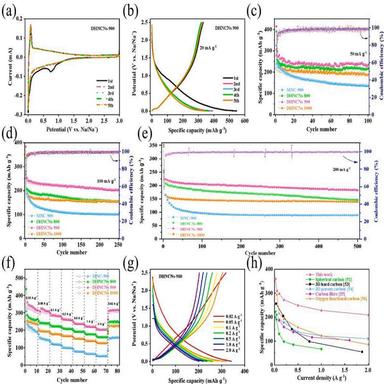
Cyclic voltammograms of the DHNCNs-900 electrode at a scanning rate of 0.2 mV s − 1 (a), charge/discharge curves of the DHNCNs-900 electrode at a current density of 20 mA g− 1 (b), cycling performance of the MNC-900 and DHNCNs-T electrodes at the current density of 50 mA g− 1 (c), cycling performance of the MNC-900 and DHNCNs-T electrodes at the current density of 100 mA g− 1 (d), and long-term cycling performance of the MNC-900 and DHNCNs-T electrodes at the current density of 200 mA g− 1 (e). Rate perform